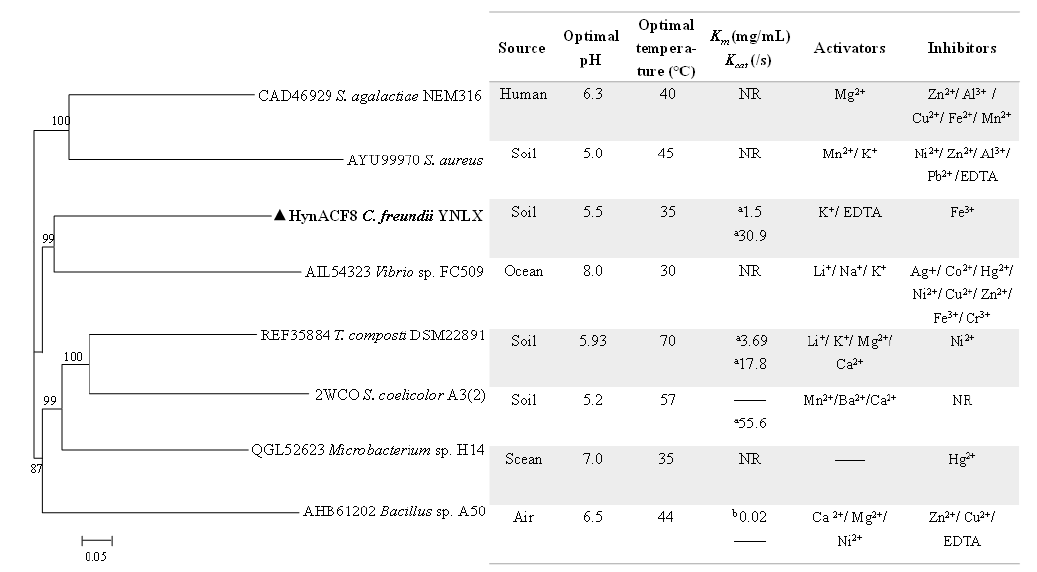
Figure 3. Phylogenetic tree constructed using the amino acid sequences of experimentally character- ized hyaluronic acid lyase. a UV spectrophotometry. One unit (U) of hyaluronic acid lyase activity was defined as the amount of enzyme formed by 1 µ mol unsaturated double bonds per minute using HA as the substrate under certain conditions. b Bovine albumin turbidimetry. One unit (U) of enzymatic activity was defined as the amount of enzyme equal to that of 1 U standard hyaluronidase for splitting hyaluronic acid in 30 min under specific